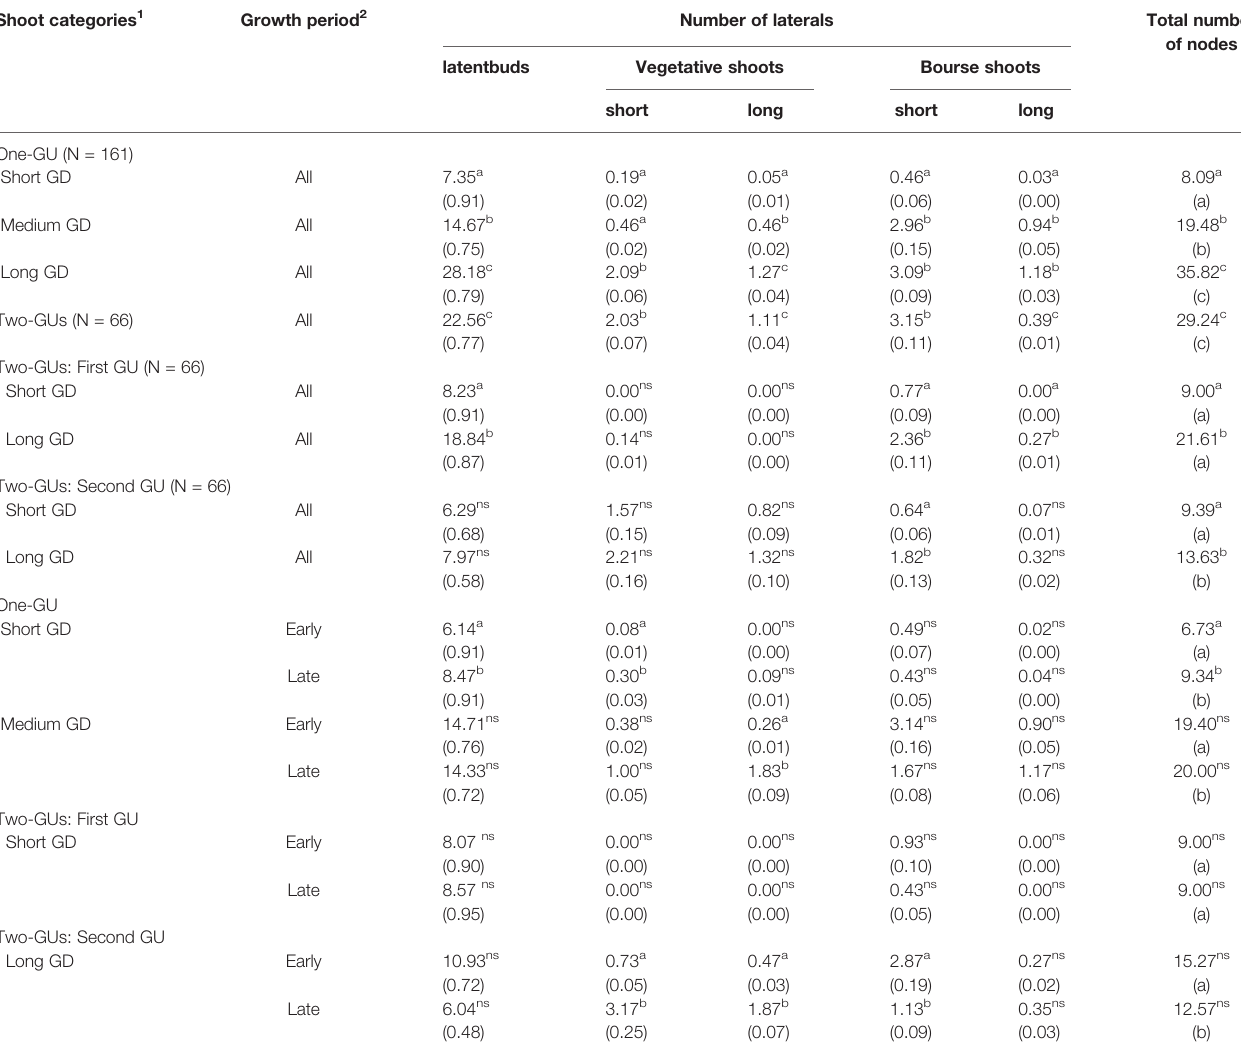
1 For the comparison of the lateral number and proportion (in parentheses) across four shoot categories (one-GU short GD, one-GU medium GD, one-GU long GD, two-GUs), different letters per column indicate signi fi cant differences (P < 0.05) according to Kruskal-Wallis test with post-hoc Dunn test and chi-squared test with post-hoc Tukey test, respectively. For the comparison of the lateral number and proportion between different GDs within the fi rst and second GUs, different letters indicate signi fi cant differences (P < 0.05) according to the Mann- Whitney test and Fisher ’ s exact test, respectively. 2 For the comparison of the lateral number and proportion between early and late growth period, different letters indicate signi fi cant differences (P < 0.05) according to the Mann-Whitney test and Fisher ’ s exact test, respectively. Ns indicates the test is non-signi fi cant (P ≥